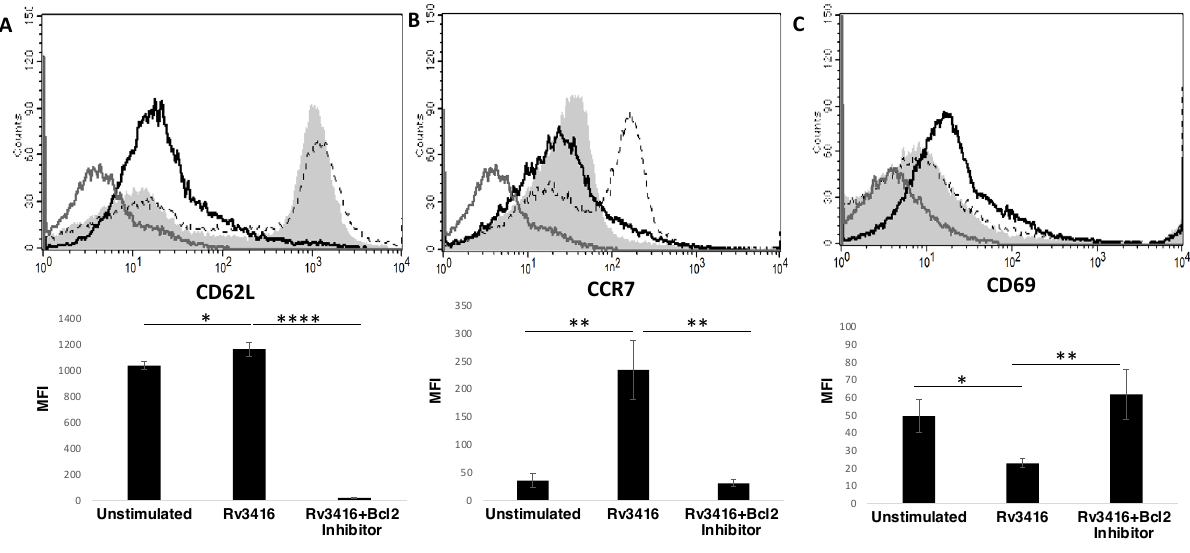
Figure 8: Bcl2 inhibited Rv3416 stimulated BMDCs induces effector phenotype in T cells. BMDCs were incubated with 10 μM Bcl2 Inhibitor for 1h followed by stimulation with 15 μg/ml Rv3416 for 24h. BMDCs were then co-cultured for 48h with T cells enriched from inguinal lymph nodes from Rv3416 immunized Balb/c mice. Following co-culture T cells were enriched with MACS and stained for the markers either with PE conjugated (CD62L and CCR7) or FITC conjugated (CD69) specific monoclonal antibodies. Shaded histograms represent unstimulated cells, dotted line represents Rv3416 stimulated BMDCs while the thick line represents Bcl2 Inhibitor treated Rv3416 stimulated cells. Thick grey line represents Isotype matched controls. Data shows a representative image of three experiments. Bar charts below each histogram represent Mean Fluorescence Intensities (MFI) of the groups. Data represents Mean ± SD of three independent experiments. For Panel A, P value between groups Unstimulated and Rv3416 is P<0.05, between Rv3416 and RFv3416+Bcl2 Inhibitor is P<0.0001. For Panel B, P value between groups Unstimulated and Rv3416 is P<0.01 and between groups Rv3416 and Rv3416+Bcl2 Inhibitor is P<0.01. For Panel C, P value between groups Unstimulated and Rv3416 is P<0.05 and between Rv3416 and Rv3416+Bcl2 Inhibitor is P<0.01. One way ANOVA was performed followed by Bonferroni’s multiple comparison post-hoc test with 95% confidence interval. * denotes statistical significance at P<0.05. ** denotes statistical significance at P<0.01 and **** denotes statistical significance at